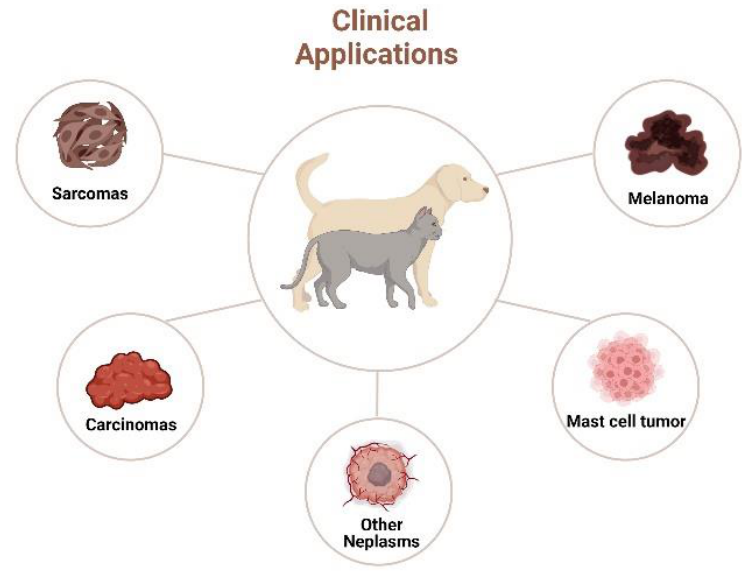
Figure 4. Clinical applications of PDT in veterinary medicine. Created with Biorender.com.